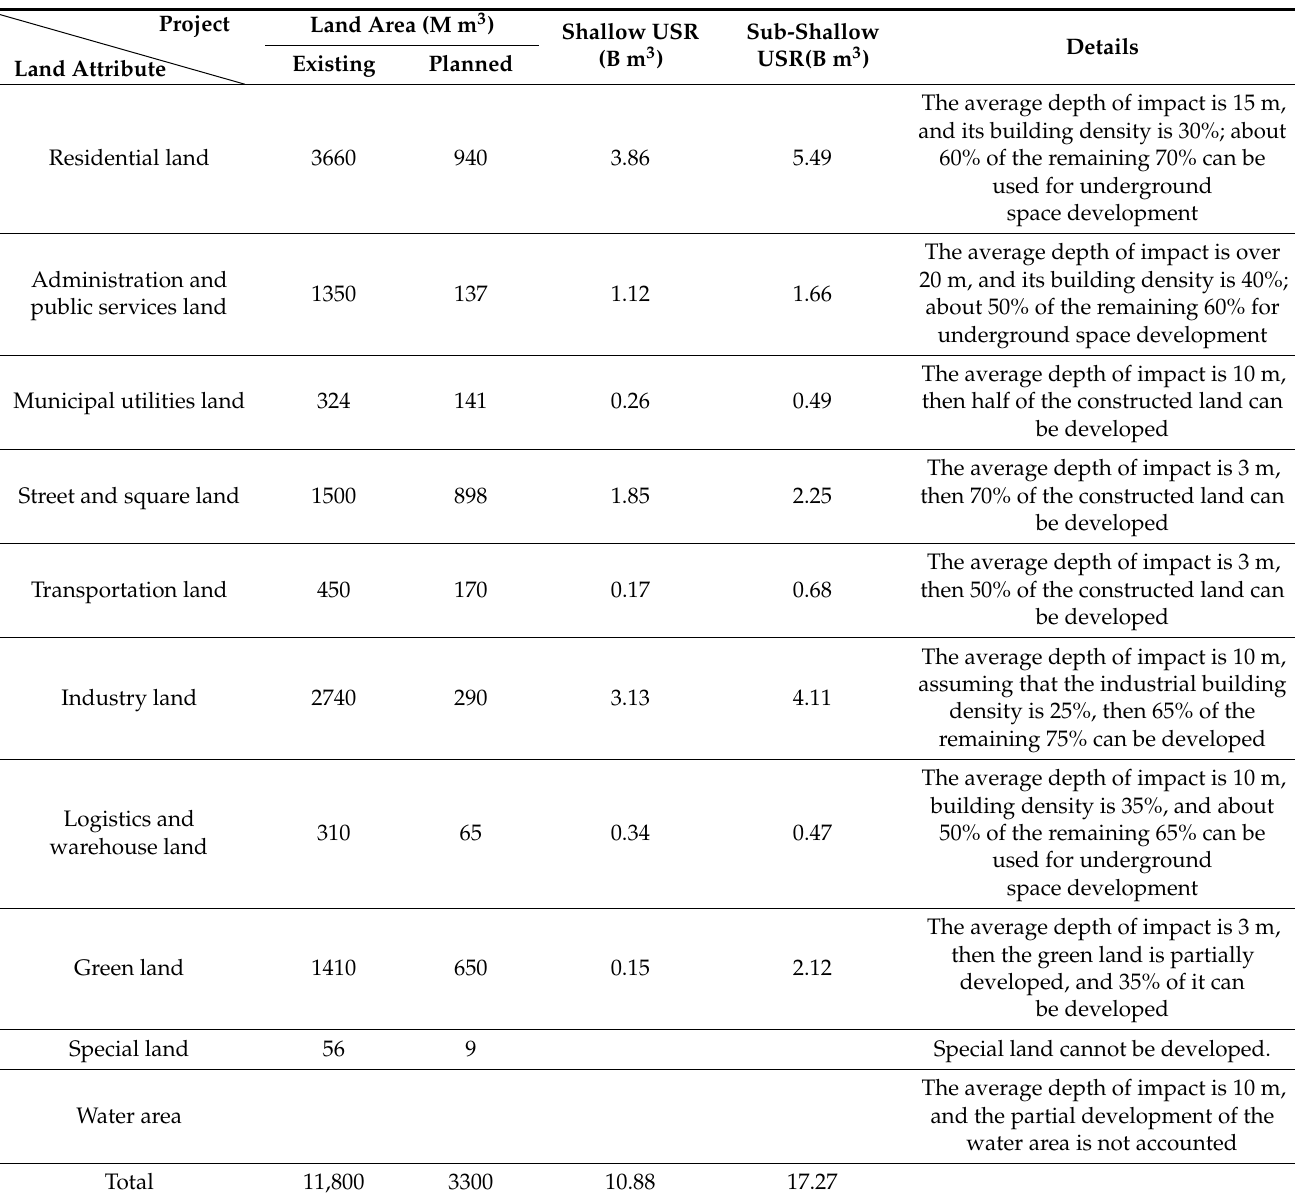
Table 11. The technical exploitation capacity of USR for Yangzhou